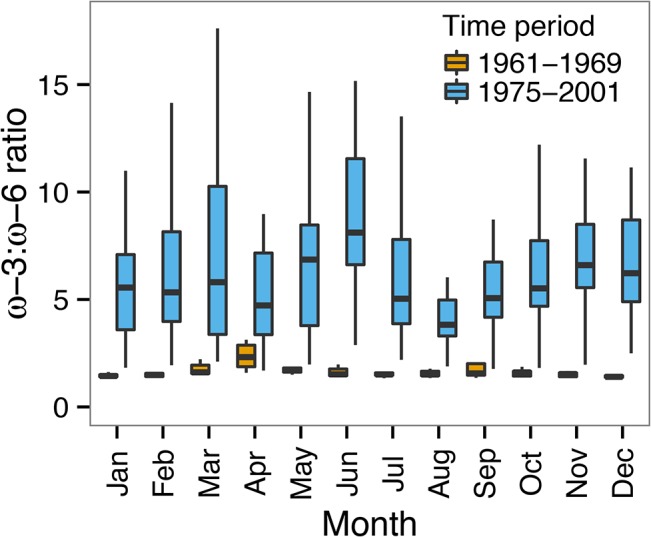
Lake Washington monthly ɷ-3:ɷ-6 fatty acid ratios calculated from phytoplankton biomass from 1961–2001.The boxplot colors represent the time periods and boxplot dimensions follow description in Fig 4. The y-axis is set to show the extent of whiskers, excluding extreme outliers with ratio values >18.